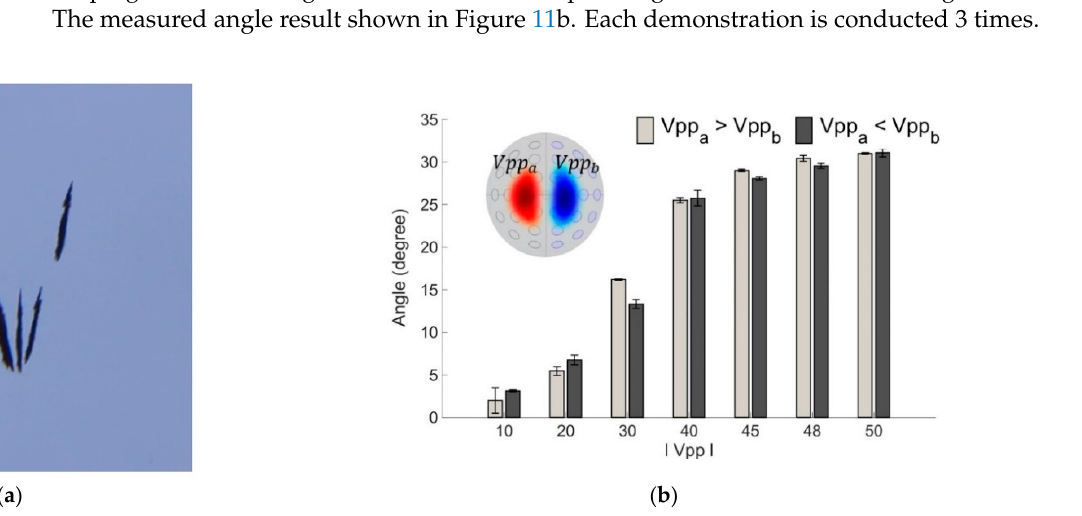
Figure 10. Demonstration of rotation control in the O ‐ XY plane: ( a ) time ‐ lapse image sequences show a nanocarrier cluster in the O ‐ XY plane (viewed from above) rotated at an arbitrary location in space (scale bar is 1 mm); ( b ) difference angle between the measured and desired angles in open ‐ loop control.